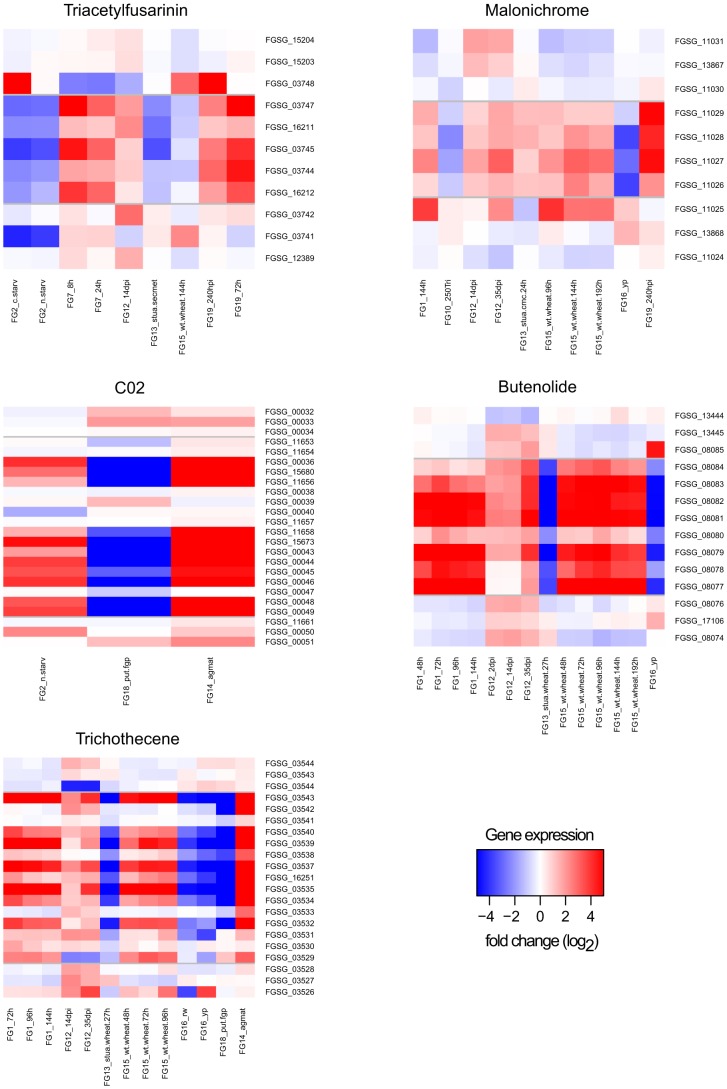
Differential gene expression heatmap of clusters and neighboring genes.Heatmaps illustrate fold changes in gene expression (log2 scale) between experimental conditions. Genes are listed in chromosomal order on y-axis. Abbreviations of experimental conditions on x-axis are according to Table 6. Horizontal grey bars show boundaries of predicted clusters.